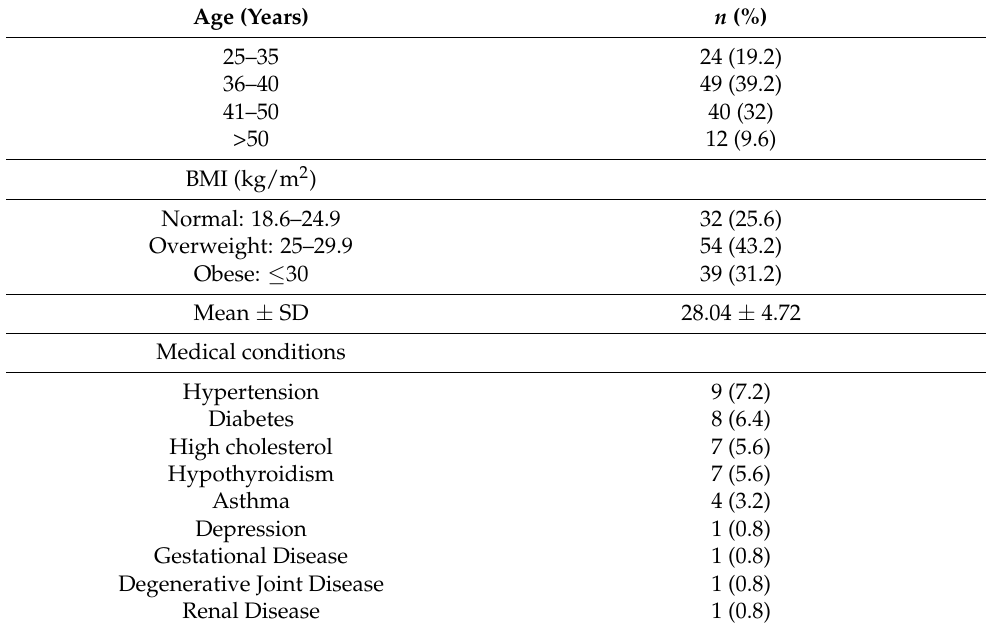
Table 1. Characteristics of the study sample ( n = 125).